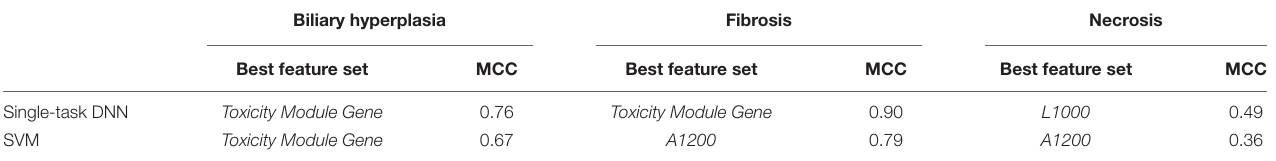
TABLE 5 | Performance of single-task DNN and SVM models using Ippolito et al.